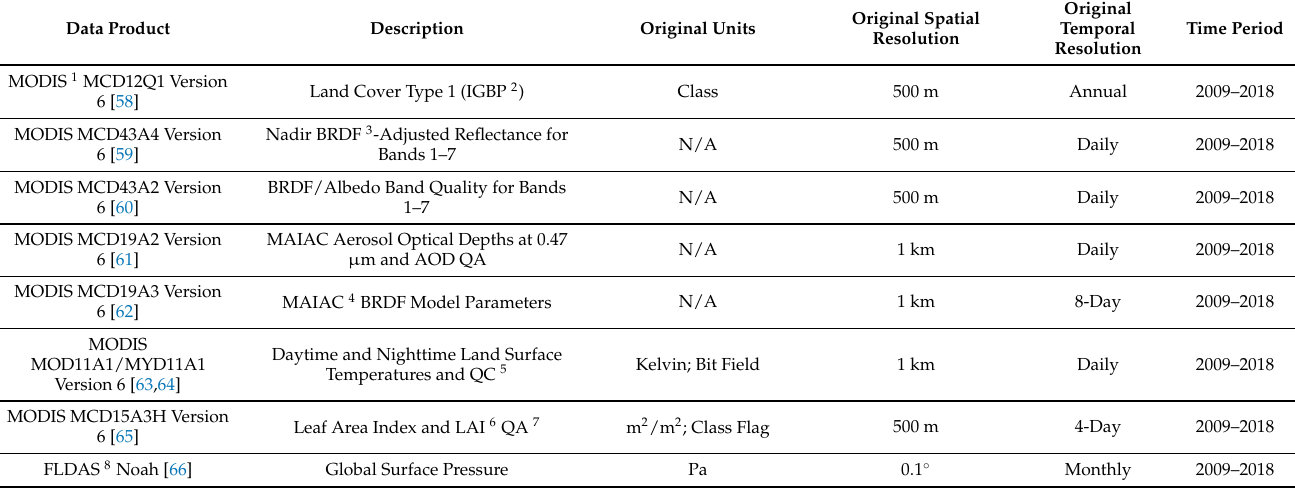
Table 1. Summary of data